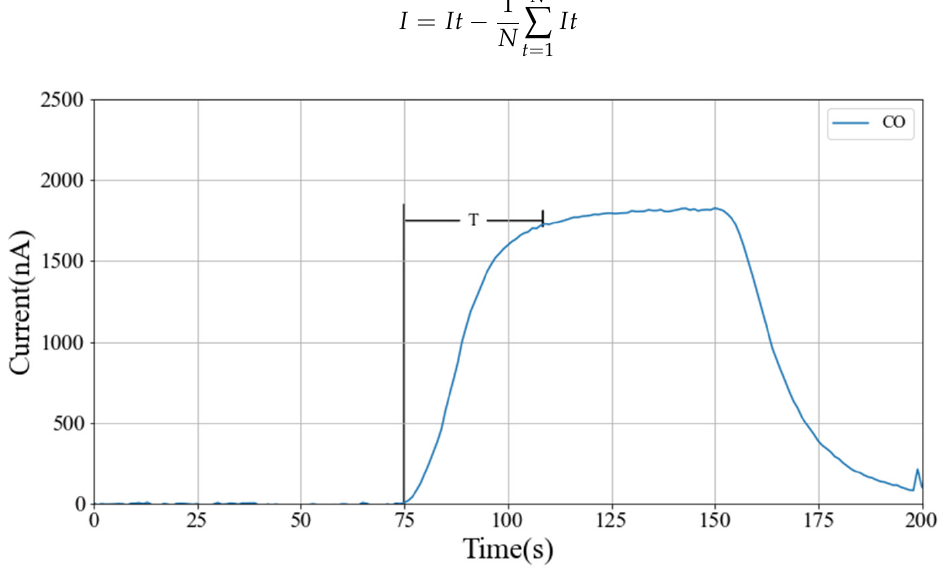
Figure 16. Response results of CO sensors.